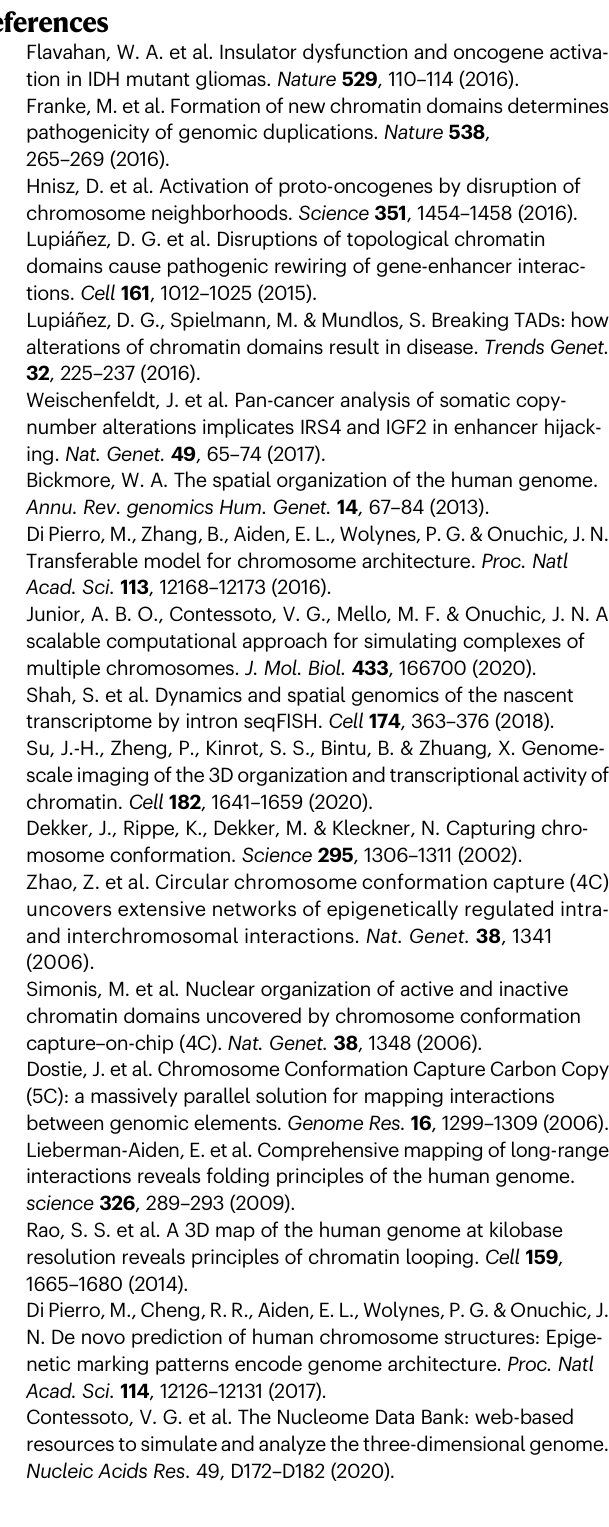
algorithm 99 . Comparisons between different normalizations are presented in the Supplementary Information